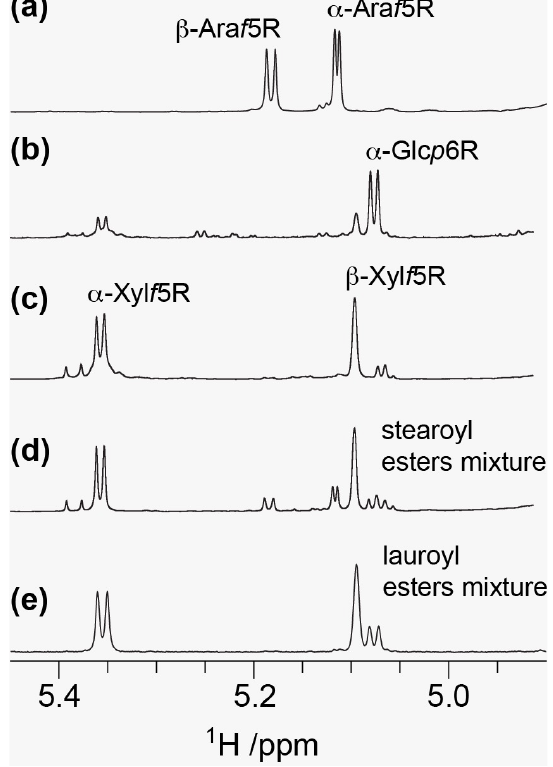
Figure 3. Selected region of the 1 H NMR spectra of ( a ) 5- O -stearoyl- L -arabinofuranose ( 6 ), ( b ) 6- O - stearoyl- D -glucopyranose ( 2 ), ( c ) 5- O -stearoyl- D -xylofuranose ( 1 ), ( d ) stearoyl esters mixture ( 1/2/3 ) and ( e ) lauroyl ester mixture ( 4/5 ), showing the anomeric resonances of the major components. The spectra of panels ( a – d ) were recorded on a Bruker Avance 500 MHz spectrometer whereas the spec- trum of panel e was recorded on a Bruker Avance III 400 MHz spectrometer. At the conditions that the experiments were recorded, the β -pyranose form of the D -glucopyranose derivatives is observed as a very minor component (cf. Figure 2c).